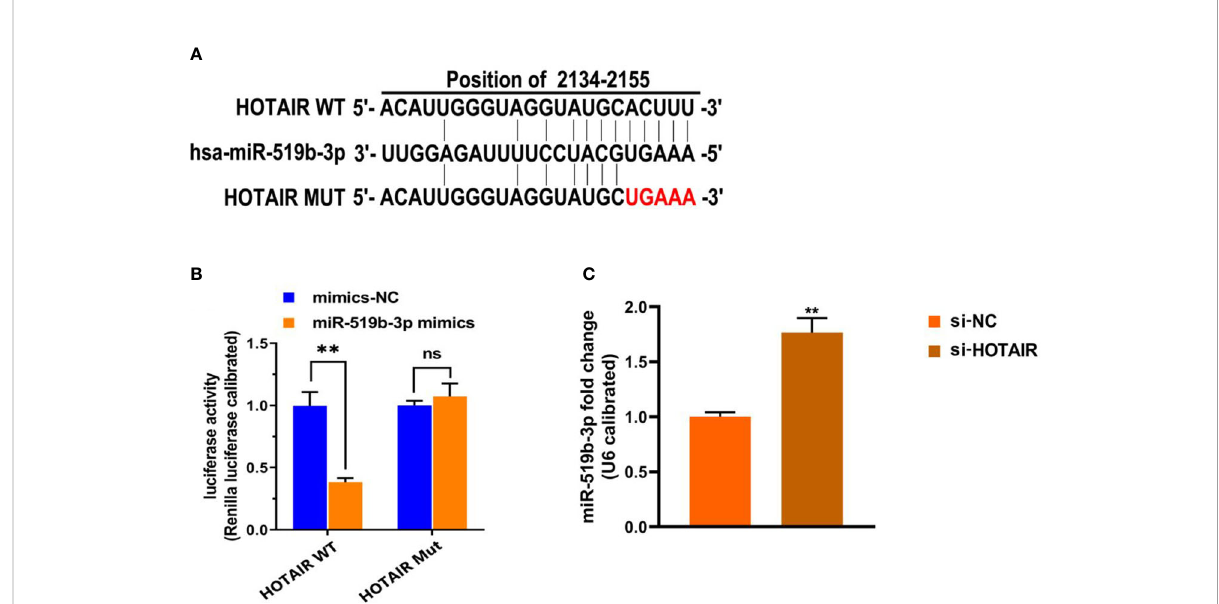
FIGURE 3 miR-519b-3p was a target gene of LncRNA HOTAIR and negatively regulated by LncRNA HOTAIR. (A) Predicted complementary sequences between LncRNA HOTAIR and miR-519b-3p, (B) Luciferase reporter assay con fi rmed that the luciferase activity decreased when LncRNA HOTAIR was bound to miR-519b-3p-wt, (C) Expression level of LncRNA HOTAIR was detected by qRT-PCR. Data are presented as the mean ± SEM, n=8 in each group. **P<0.01 vs. mimics-NC or si-NC. ns, not signi fi